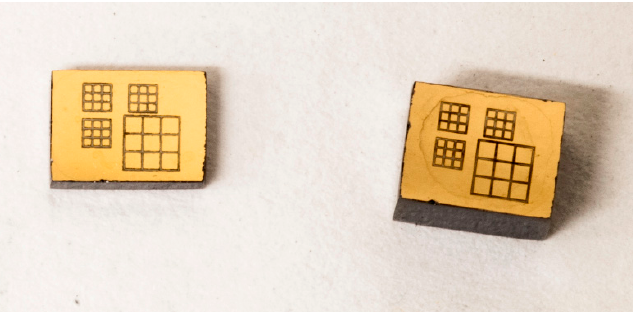
Figure 2. Anode layout of the investigated CZT pixel detectors. Each detector is characterized by four arrays of 3 × 3 pixels with pixel pitches of 500 and 250 μ m.